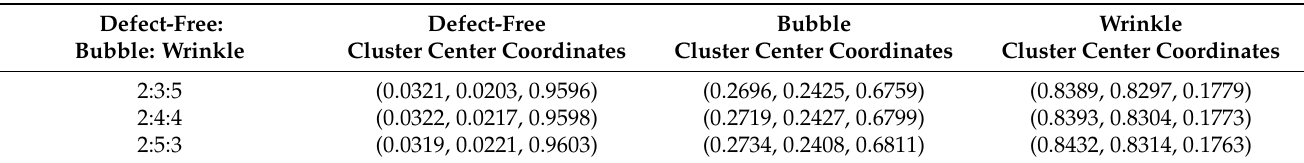
Table 5. The final cluster center of three surface morphologies with different proportions.